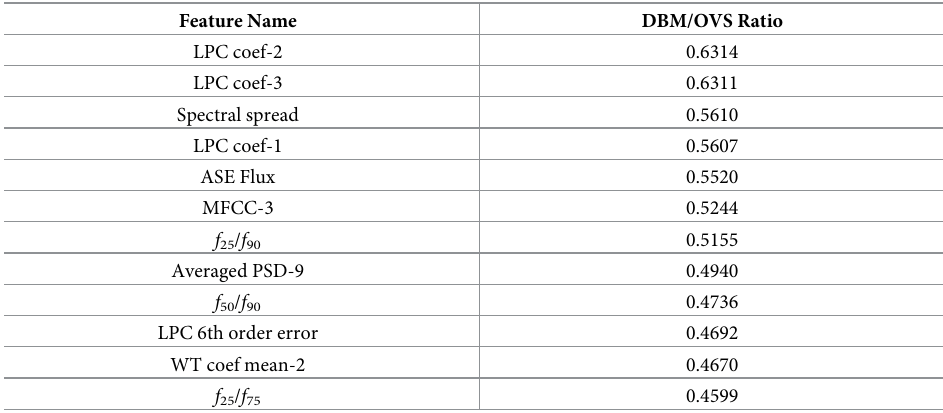
Table 6. Features with highest ratio of DBM and OVS.